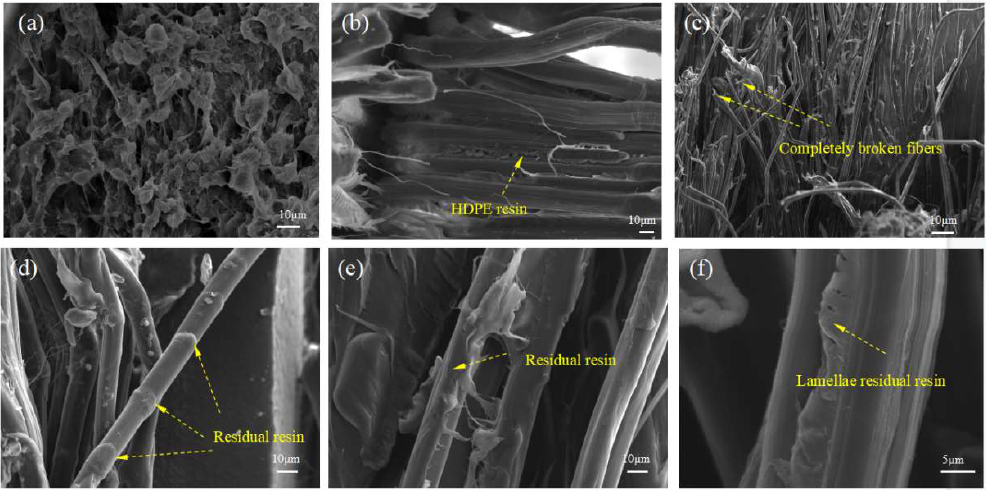
Figure 12. Microstructures of fractured surfaces of SRCs after tensile tests at a printing temperature of 150 °C. ( a ) Fractured surface of the HDPE matrix. ( b , c ) Longitudinal section of the tested samples. ( d – f ) Detail of fractured UHMWPE fibers.